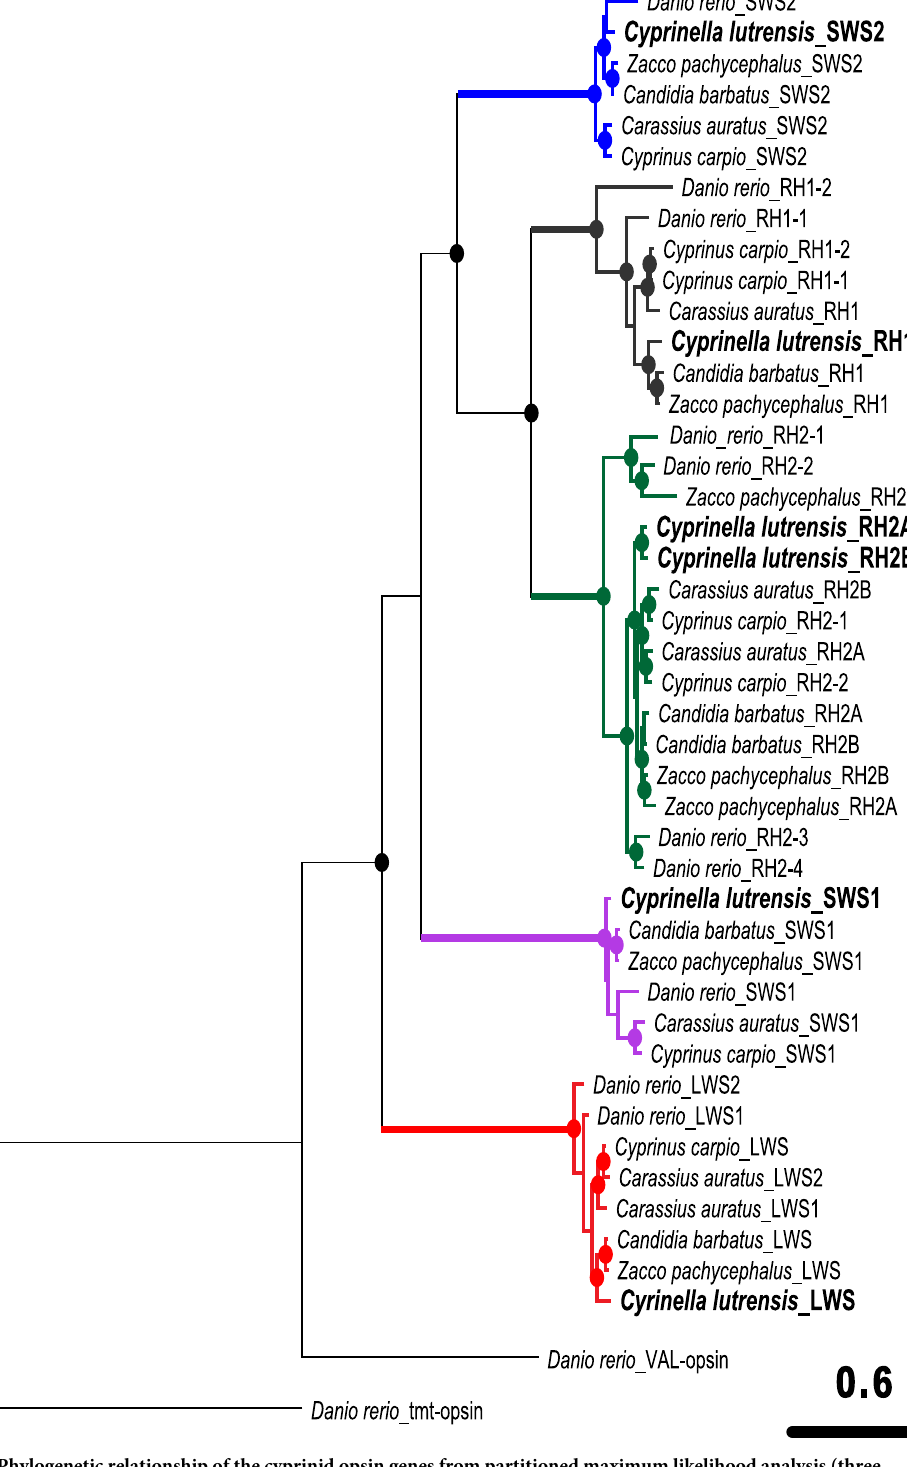
Fig 1. Phylogenetic relationship of the cyprinid opsin genes from partitioned maximum likelihood analysis (three partitions). The opsin gene sequences of the red shiner cloned in this study are in boldface. Solid circles on branch nodes indicate statistically robust nodes with bootstrapping values � 70. Branch color of each opsin family represents its general λ max range. SWS1 ’s is ultraviolet light, SWS2 ’s is blue light, RH2 ’s is green light, and LWS ’s is red light; also, RH1 ’s is scotopic vision.